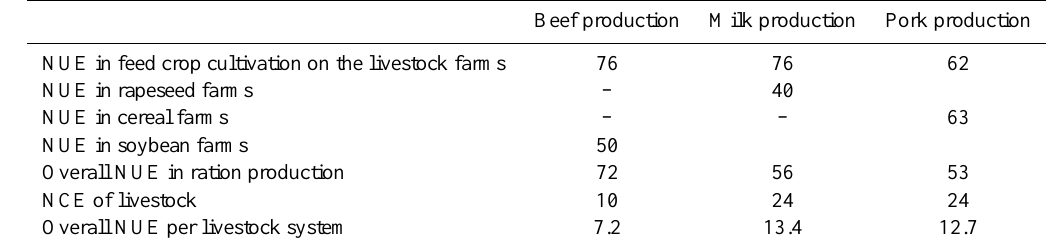
Table 2. NUE in feed production per crop and livestock farm and NCE of the livestock for beef, milk and pork production. All numbers are in %.